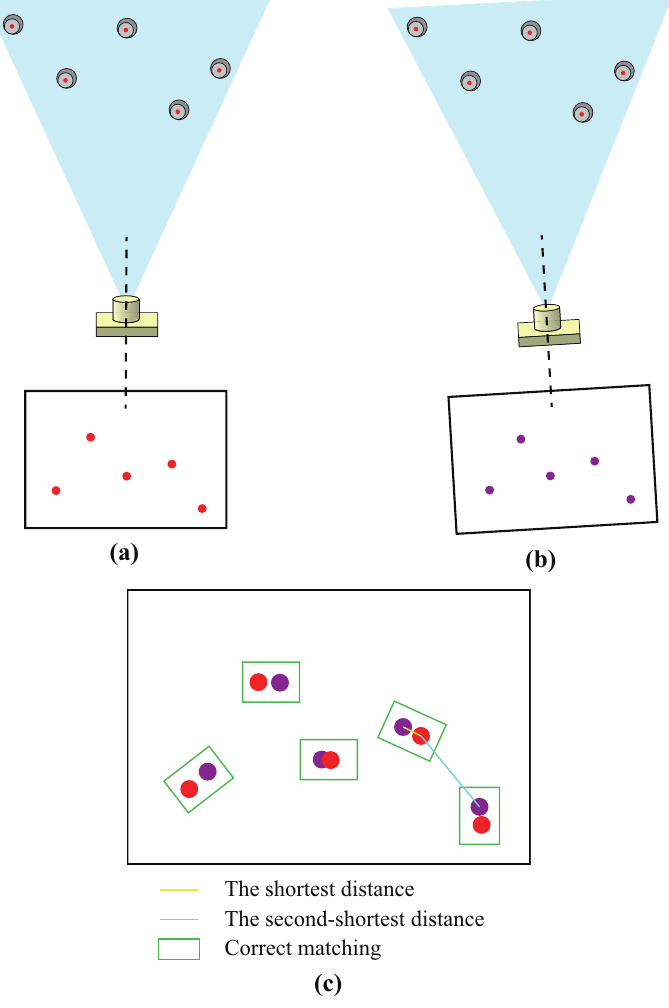
Figure 6. Feature points matching: ( a ) real image with real pose, ( b ) predicted image with estimated pose, and ( c ) nearest neighbor matching